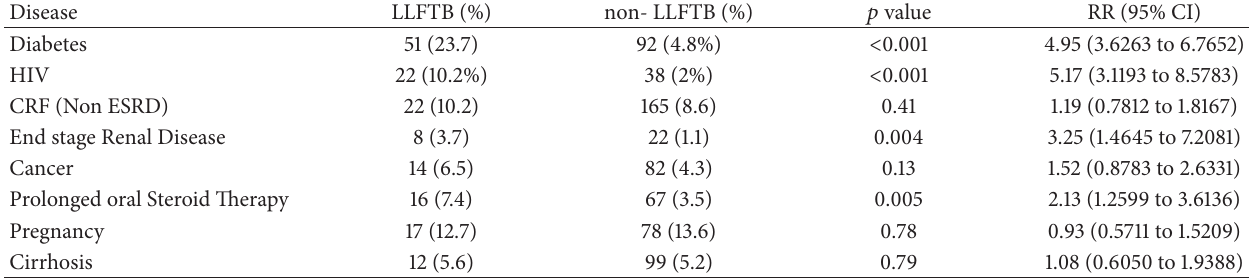
Table 4: Association of different diseases with lower lung field tuberculosis (LLFTB) and non lower lung field tuberculosis (non- LLFTB)